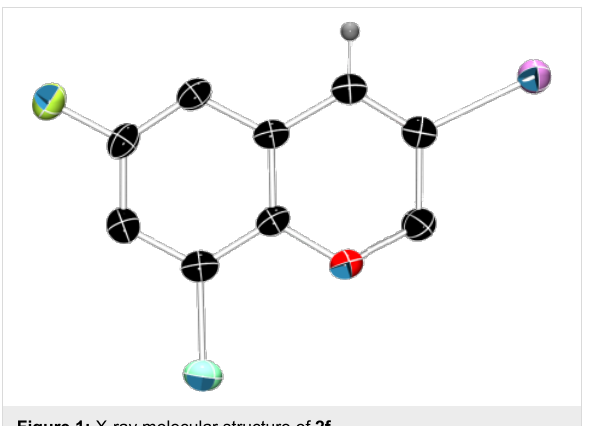
Figure 1: X-ray molecular structure of 2f